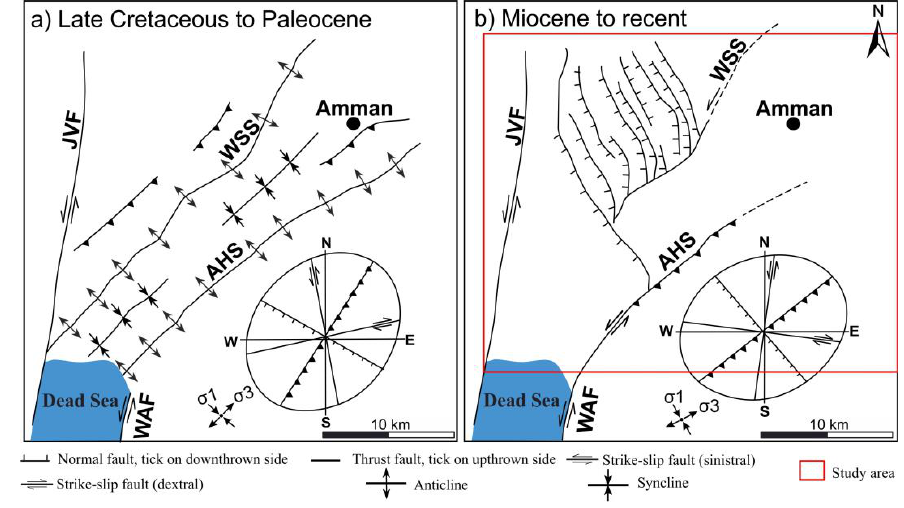
Figure 8. Schematic sketch of the tectonic evolution of the WSS and the AHS modified from Al-Awabdeh et al. [19] ( a ) from the Late Cretaceous to Paleocene period; and ( b ) the present-day configuration of the WSS and the AHS due to the Miocene reactivation by the transpressional stress field of the Dead Sea Transform Fault (DSTF). The stress field orientation is based on [17,60,83,112]. AHS: Amman-Hallabat Structure; JVF: Jordan Valley Fault; WAF: Wadi Araba Fault; and WSS: Wadi Shueib Structure.